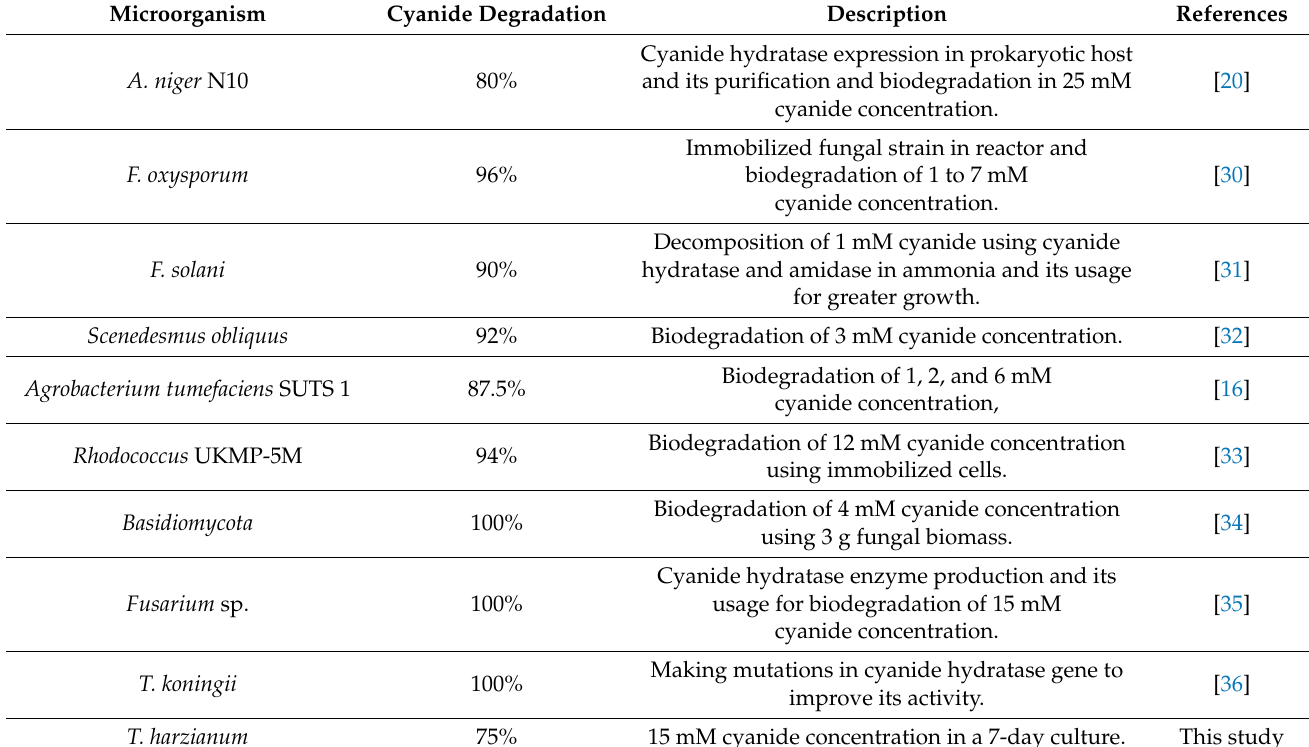
Table 4. Comparison of the rate of cyanide biodegradation through different microorganisms.